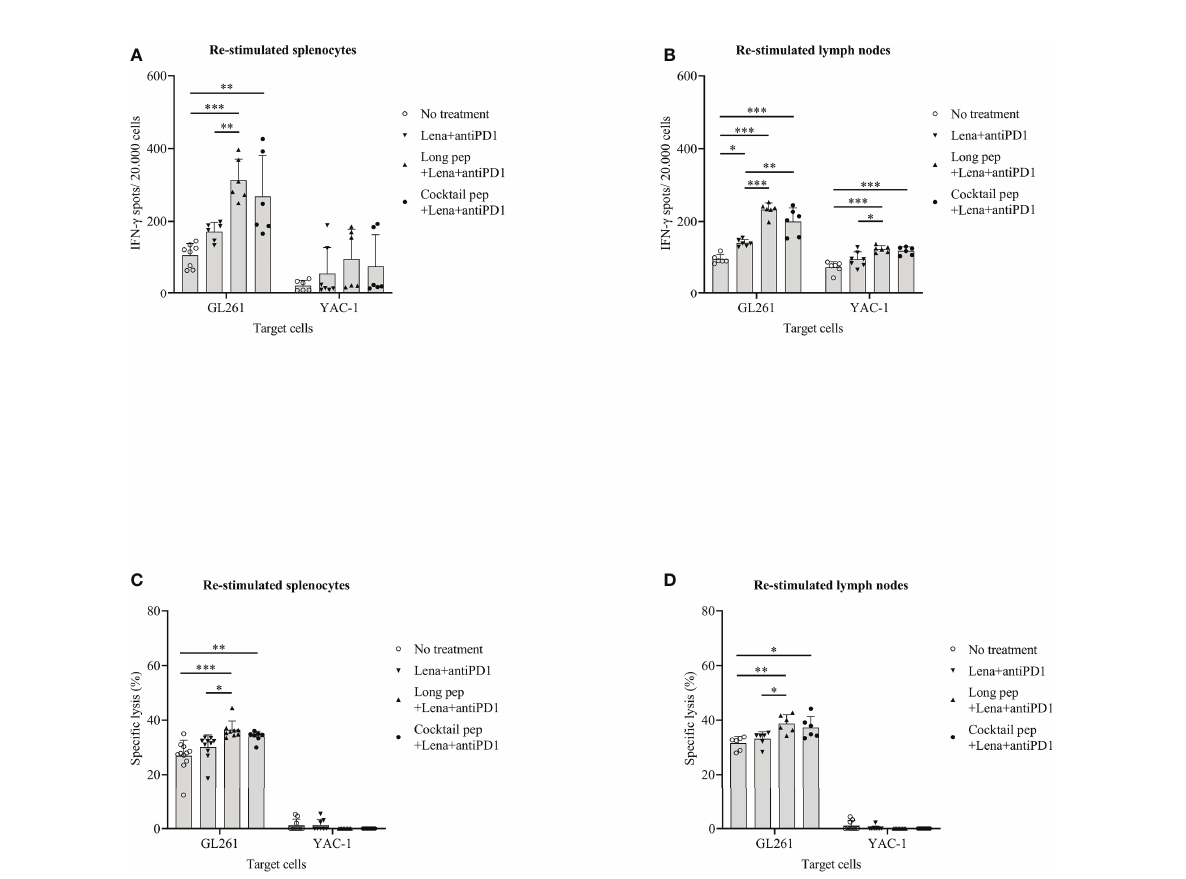
FIGURE 5 The cytotoxic T lymphocyte (CTL)-cell-mediated immune response of the re-stimulated splenocytes and lymph nodes from non-vaccinated and vaccinated mice were analyzed. IFN- g secreted by re-stimulated splenocytes and lymph nodes when co-cultured with GL261 target cancer cells (No treatment: n = 8 and n = 6, Lena+anti-PD1: n = 6 and n = 6, long pep+Lena+anti-PD1: n = 6 and n = 6, and cocktail pep+Lena+anti- PD1: n = 6 and n = 6, respectively), and YAC-1 target cancer cells (No treatment: n = 6 and n = 6, Lena+anti-PD1: n = 7 and n = 7, long pep+Lena+anti-PD1: n = 6 and n = 6, and cocktail pep+Lena+anti-PD1: n = 6 and n = 6, respectively) was measured using the IFN- g ELISPOT assay (A, B) . The speci fi c killing effects of re-stimulated splenocytes and lymph nodes against GL261 target cancer cells (No treatment: n = 11 and n = 6, Lena+anti-PD1: n = 10 and n = 6, long pep+Lena+anti-PD1: n = 9 and n = 6, and cocktail pep+Lena+anti-PD1: n = 7 and n = 6, respectively), and YAC-1 target cancer cells (No treatment: n = 9 and n = 9, Lena+anti-PD1: n = 8 and n = 9, long pep+Lena+anti-PD1: n = 9 and n = 9, and cocktail pep+Lena+anti-PD1: n = 9 and n = 9, respectively) were measured using an LDH assay (C, D) . The GL261 and YAC-1 cell lines were used as speci fi c and non-speci fi c target cells for CTL sensitivity, respectively. All data is shown as the mean ± standard deviation (SD). No treatment: no treatment group; Long pep: long multi-epitope peptide; Long pep+Lena: long multi-epitope peptide plus lenalidomide; Lena+anti-PD1: Lenalidomide plus anti-PD1; Long pep+Lena+anti-PD1: long multi-epitope peptide plus lenalidomide and anti-PD1; Cocktail pep+Lena+anti-PD1: cocktail of multi-epitope peptide plus lenalidomide and anti-PD1. p< 0.05 (*), p< 0.001 (**), p< 0.0001